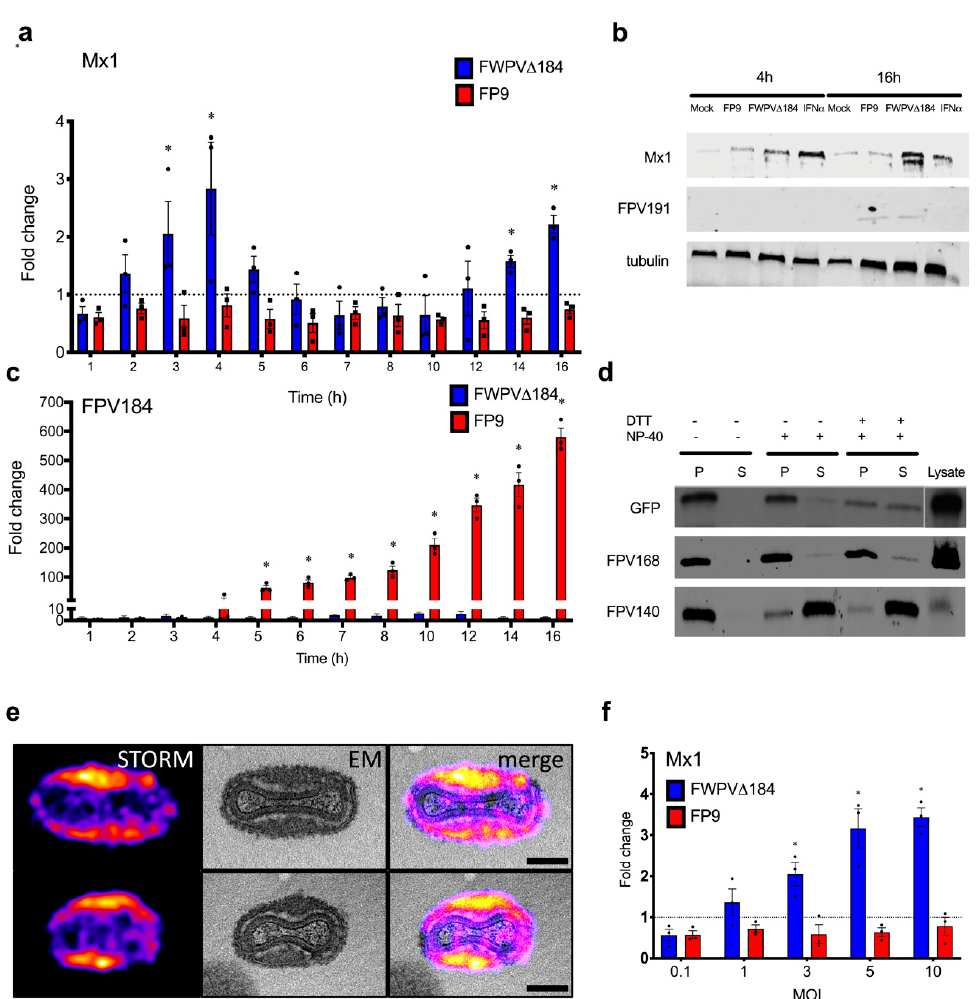
Figure 3. FPV184 mediates early suppression of ISGs through lateral body (LB) packaging. ( a ) Kinetics of Mx1 mRNA expression presented as scatter dot plots (means ± SEM, n = 3) following infection of CEFs with FWPV ∆ 184 and the wild-type FP9 viruses (MOI: 5, 1 h adsorption), measured by qPCR. ● and ■ represent replicate values for infection with FWPV ∆ 184 or FP9 respectively. ( b ) Western blot showing protein expression of chicken Mx1, late-expressed FPV191 and anti-tubulin at 4 and 16 h p.i. infection of CEFs with FP9 and FWPV ∆ 184 (MOI: 5) and treatment with IFN- α (1000 IU / mL). ( c ) Kinetics of FPV184 expression presented as scatter dot plots (means ± SEM, n = 3) following infection of CEFs with FWPV ∆ 184 and wild-type FP9 viruses, measured by qRT-PCR. ( d ) Purified particles of the virus, with EGFP fused with FPV184, were treated with either NP-40 and/or dithothreitol (DTT), centrifuged to separate the pellet (P) from supernatant (S) fractions, then subjected to SDS/PAGE and Western blotting. Immunodetection was performed with anti-GFP antibody to detect GFP fusion protein(s) and monoclonal antibodies against FWPV structural proteins FPV140 (localised on mature virions’ membrane) and FPV168 (localised in the virion core) [37]. ( e ) Correlative super-resolution light and electron microscopy of purified recombinant viruses, which have EGFP fused with FPV184 and were immunolabelled with anti-GFP nanobody. STORM images of the lateral body protein were registered with electron microscopy (EM) micrographs. Two representative virions are shown at higher magnification in upper and lower panels (i and ii). Scale bars: 300 nm. An overview is shown in Figure S2. ( f ) mRNA expression levels of Mx1 in CEFs at 4 h p.i. infected with FP9 or FWPV ∆ 184 using different MOIs (0.1, 1, 3, 5 and 10), measured by qPCR, and presented as scatter dot plots. ( a , c , f ) Columns represent fold-change (means ± SEM, n = 3) compared to mock-infected CEFs; two-way ANOVA with a Tukey’s posthoc test was used to analyse the data. * p <